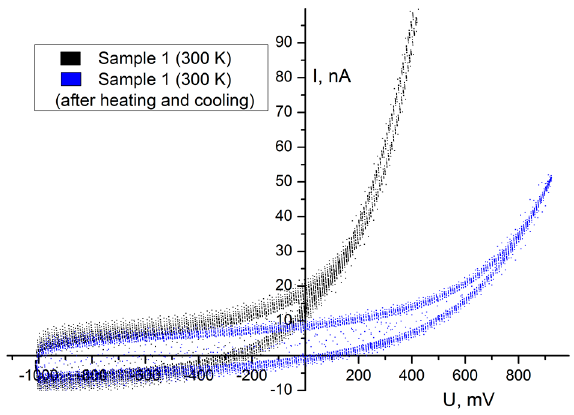
Figure 6. Investigation of volt-ampere characteristics (VAC) of Al/nc-Si/Al structures measured at 300K: (black curve) before heating, (blue curve) after heating and recooling.